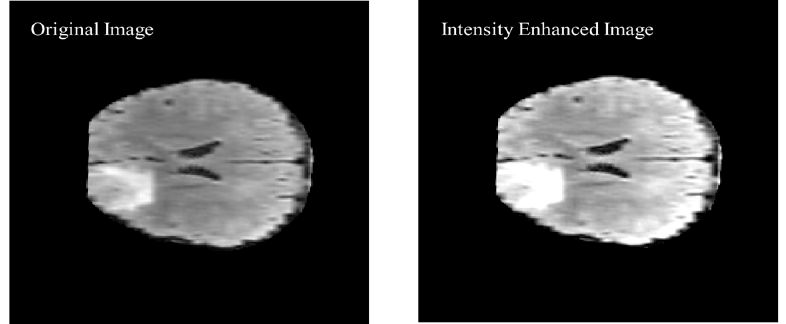
Figure 10. Visual comparison of the original image and intensity enhanced image.